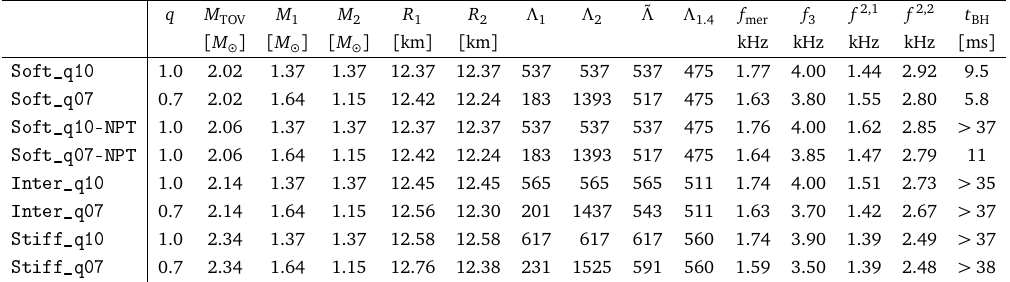
Table 1: Properties of cold non-spinning isolated neutron stars used in the construc- tion of the binary initial data. Specifically, for each model considered, we list the mass ratio, q ; the maximum non-rotating mass, M ; the gravitational mass of each TOV object at infinite separation, M < ; the proper radius of each object, R < ; the 1 / 2 > 1 / 2 > tidal deformability of each object, Λ < ; the binary tidal deformability, ˜ Λ ; the tidal 1 / 2 > deformability of a 1.4 M (cid:12) NS, Λ ; the instantaneous frequency at the maximum 1.4 GW strain amplitude, f ; the characteristic frequencies of the post-merger phase, mer f , f 2,1 , f 2,2 ; and the collapse time to black hole formation, t , for the configura- 3 BH tions that collapsed within the evolution time. q M TOV M 1 M 2 R 1 Λ 1 Λ 2 ˜ Λ Λ